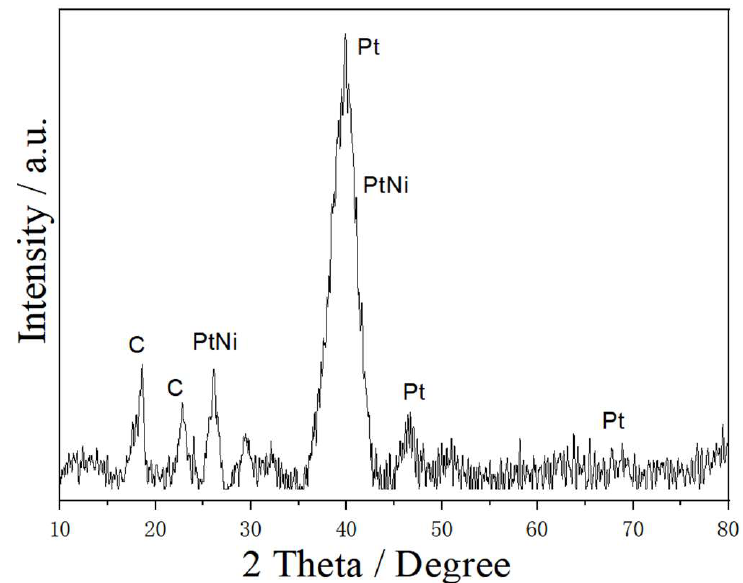
Figure 1. XRD patterns of PtNi/S-(N)rGO catalyst.